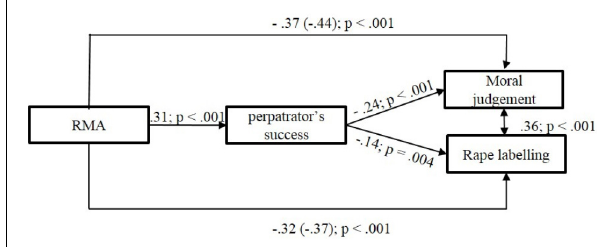
FIGURE 2 | Standardized path model of the direct and indirect effects on Moral judgment and Rape labeling in Study